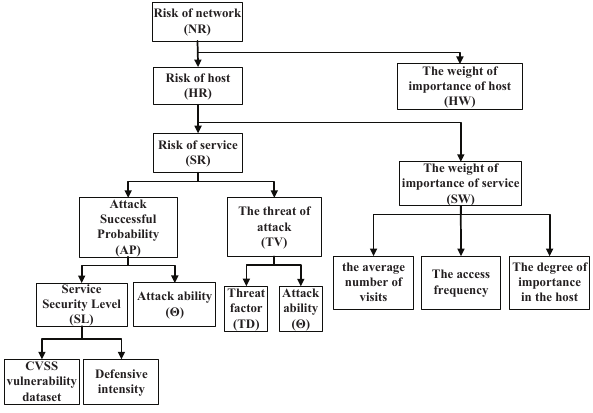
Figure 1: The Real-time Network Security Risk As- sessment